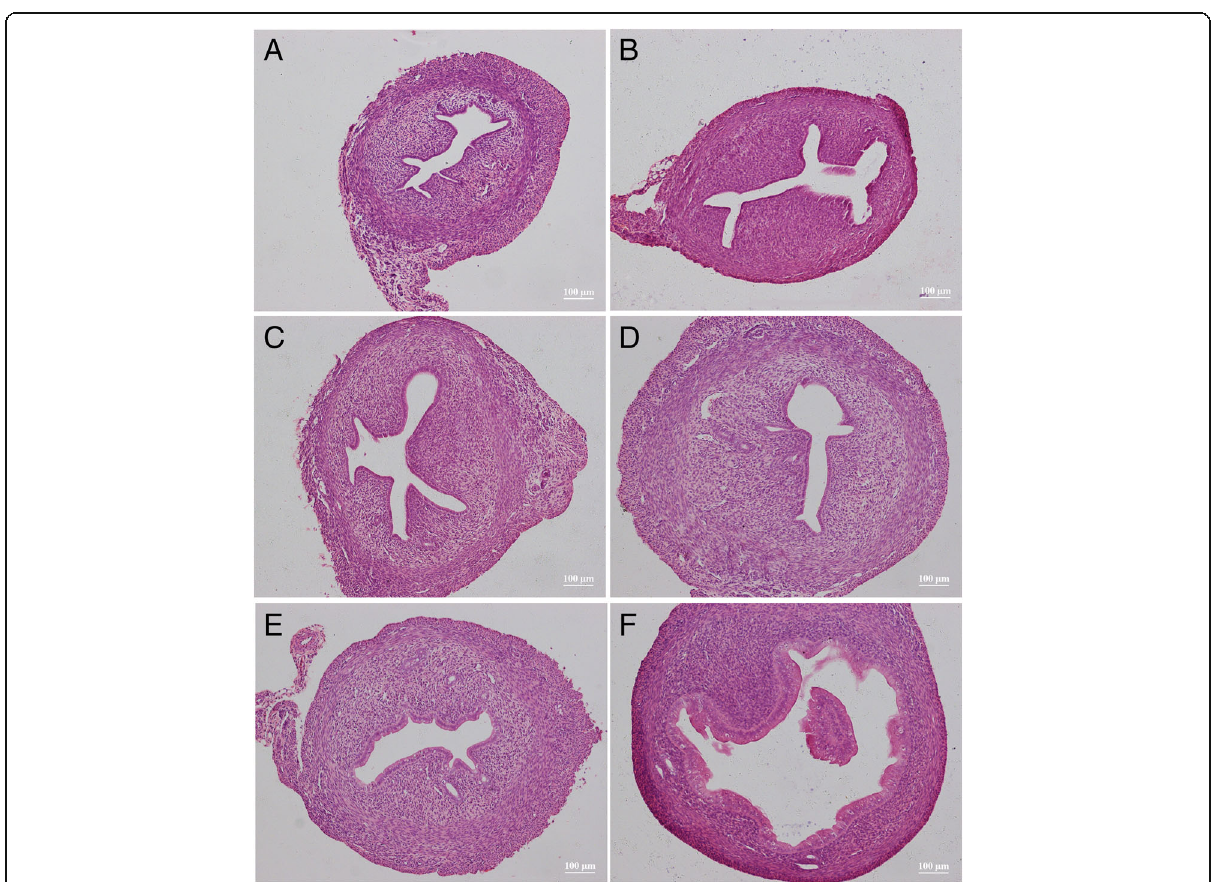
Fig. 5 Hematoxylin and eosin stained images of the uterus from solvent control ( a ) and rats receiving NP dosages of 15 ( b ), 30 ( c ), 60 ( d ), 120 ( e ), and 240 mg/kg body weight ( f